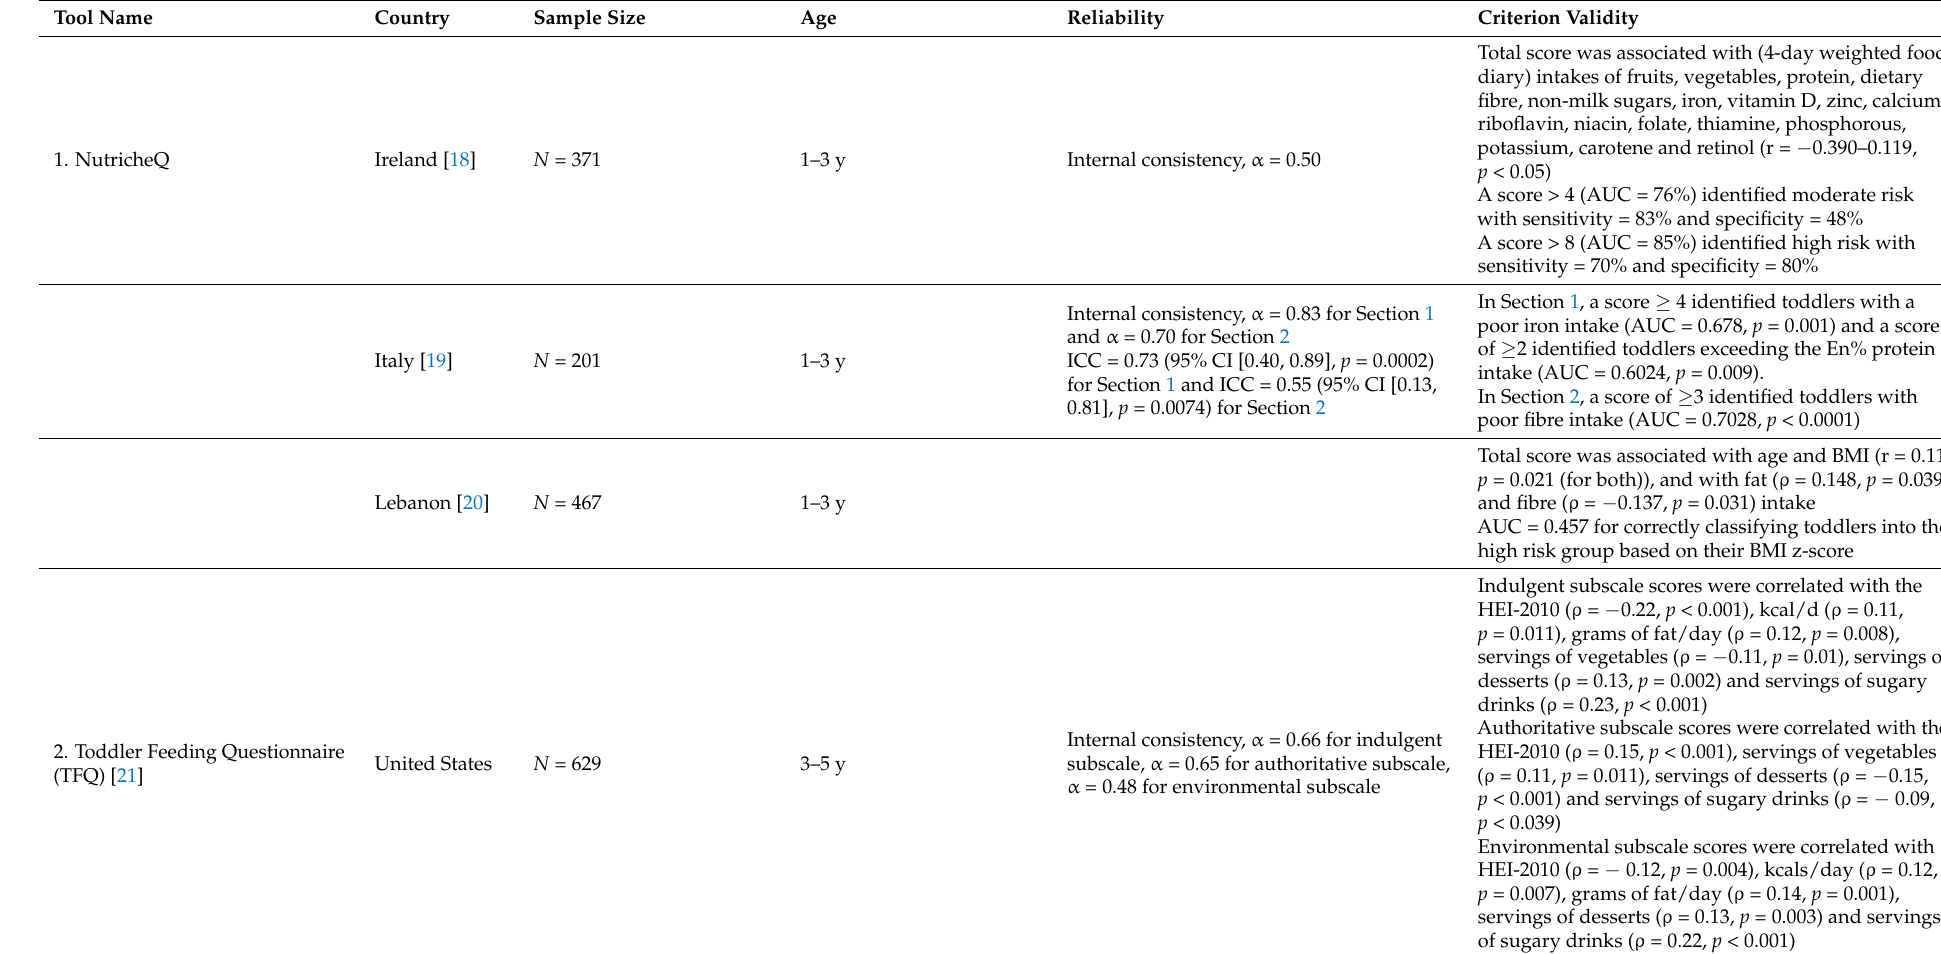
Table 4. Psychometric properties of lifestyle screening tools for children in the community